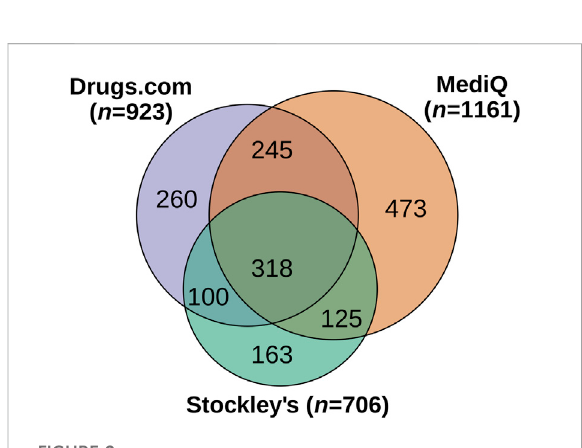
FIGURE 2 Overlap of potential drug-drug interactions among the three databases. A total of 1,684 different pDDIs were identi fi ed for the patient cohort ( N = 627). The Venn diagram shows the intersections of pDDIs between the databases. The circles and intersecting sets are drawn approximately to scale. pDDI, potential drug-drug